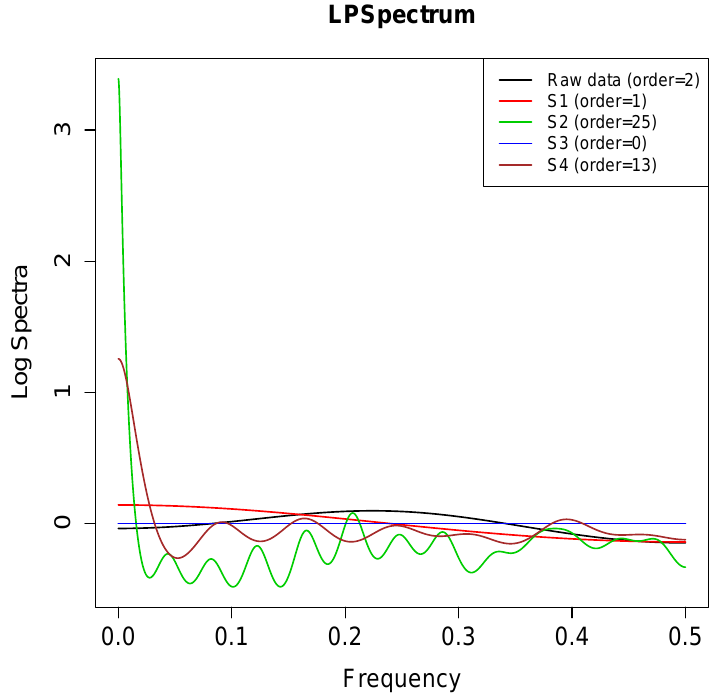
Figure 11. LPSpectrum: AR spectral density estimate for S&P 500 return data. Order selected by the BIC method. This provides a diagnostic tool for providing evidence of hidden periodicities in non-Gaussian nonlinear time